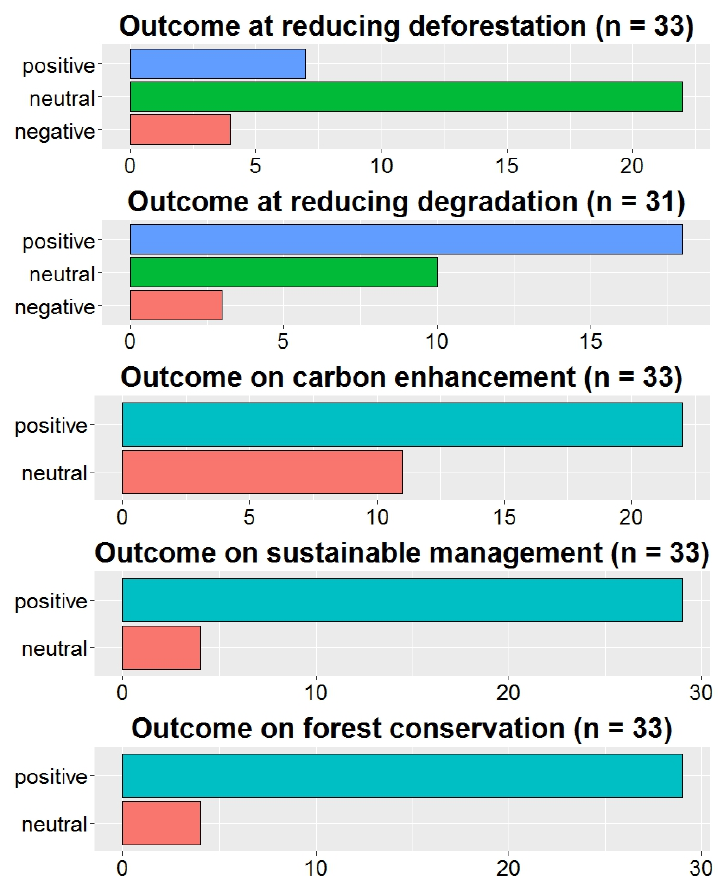
Figure 4. Frequency of the outcome identified for the five REDD+ activities evaluated in this systematic review. The number of studies reporting on each criterion is indicated as the sample size ( n ).